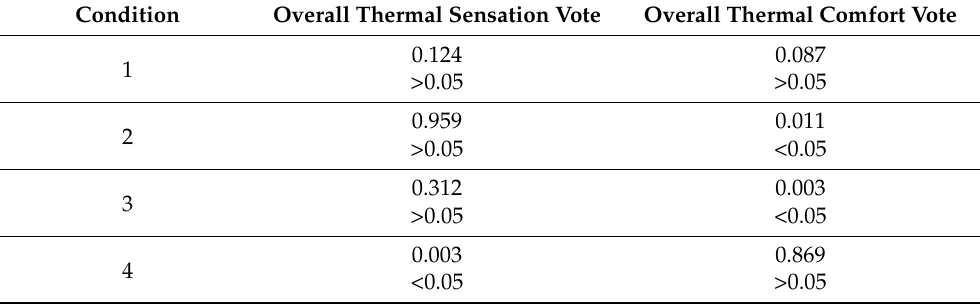
Table 8. Mann–Whitney U test for the overall thermal sensation vote and overall thermal comfort vote of preschool children and young